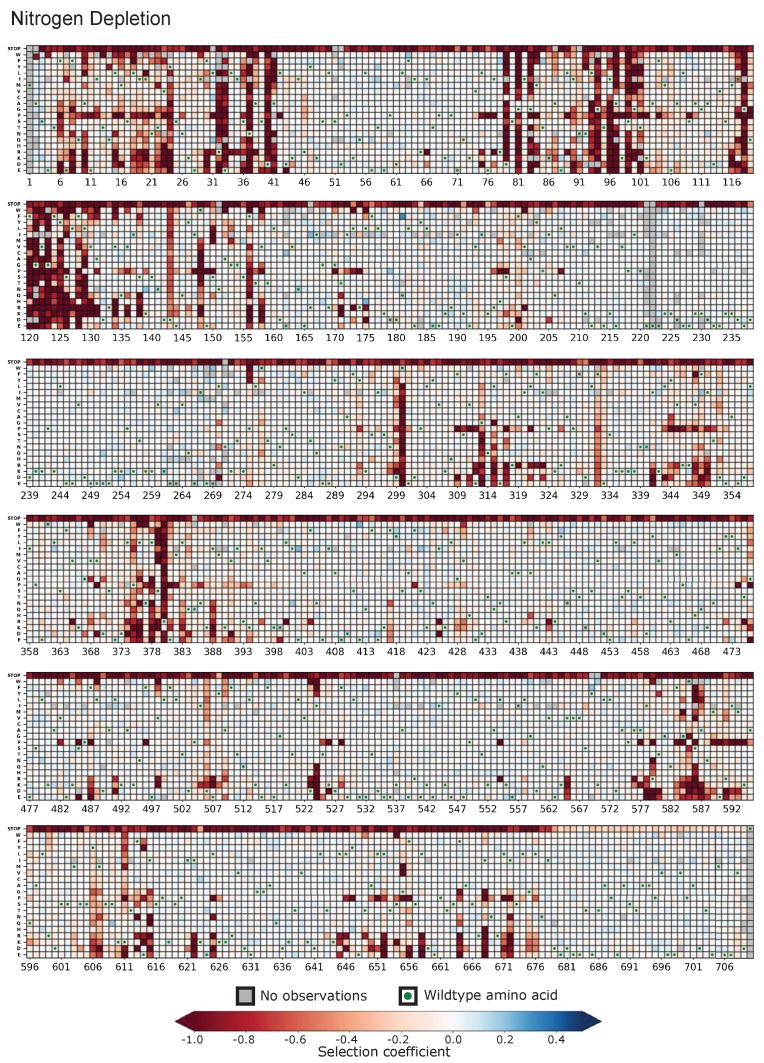
Heatmap representation of the fitness map observed for single amino acid changes of Hsp90 in nitrogen depletion.